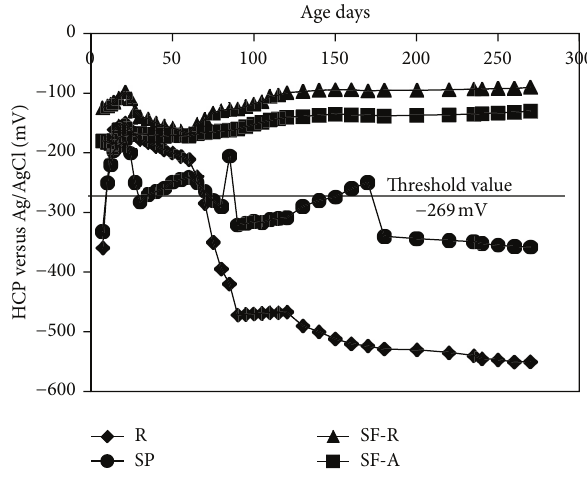
Figure 4: Half-cell potentials (HSPs) with